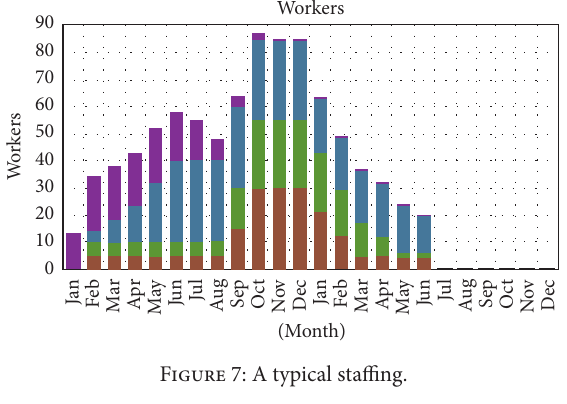
Figure 7: A typical staffing.